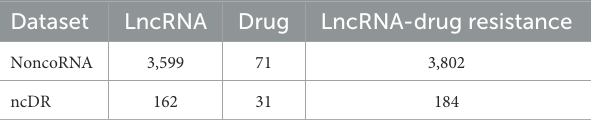
TABLE 1 Details of lncRNA-drug resistance